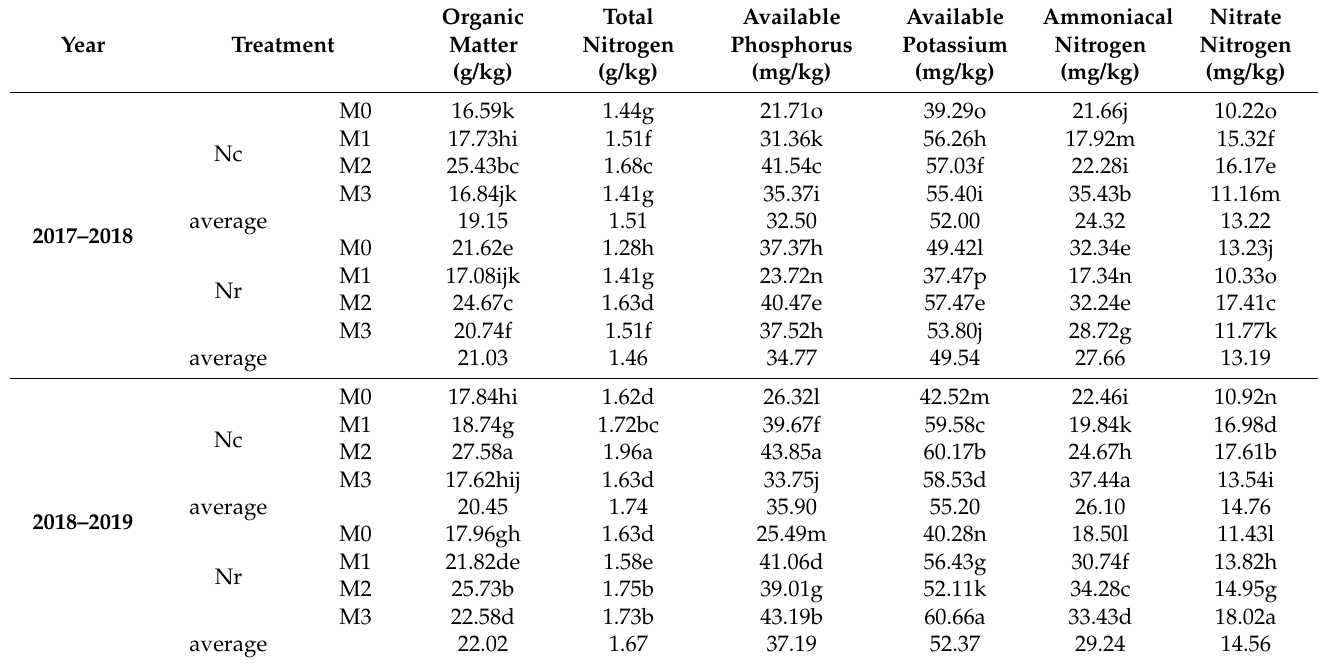
Table 1. The effects of N fertilizer management on the nutrient contents of the paddy field at the maturity